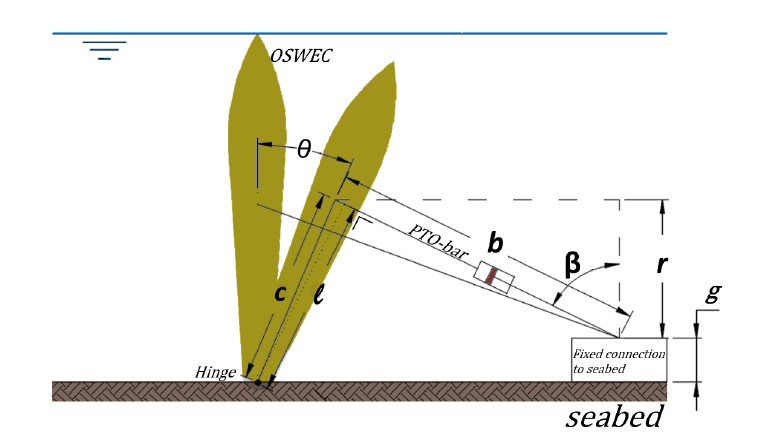
Figure 8. Hydraulic PTO system working principle of a generic OSWEC